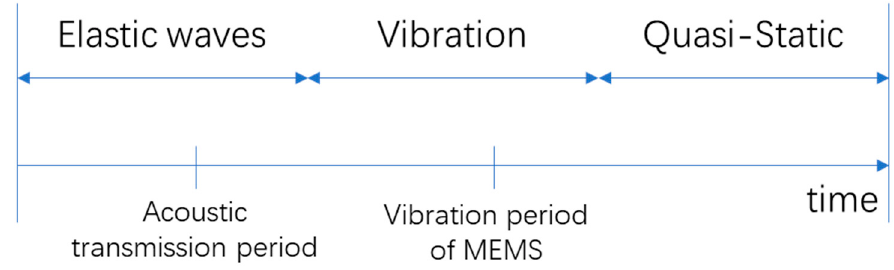
Figure 3. The three types of response modes [30].